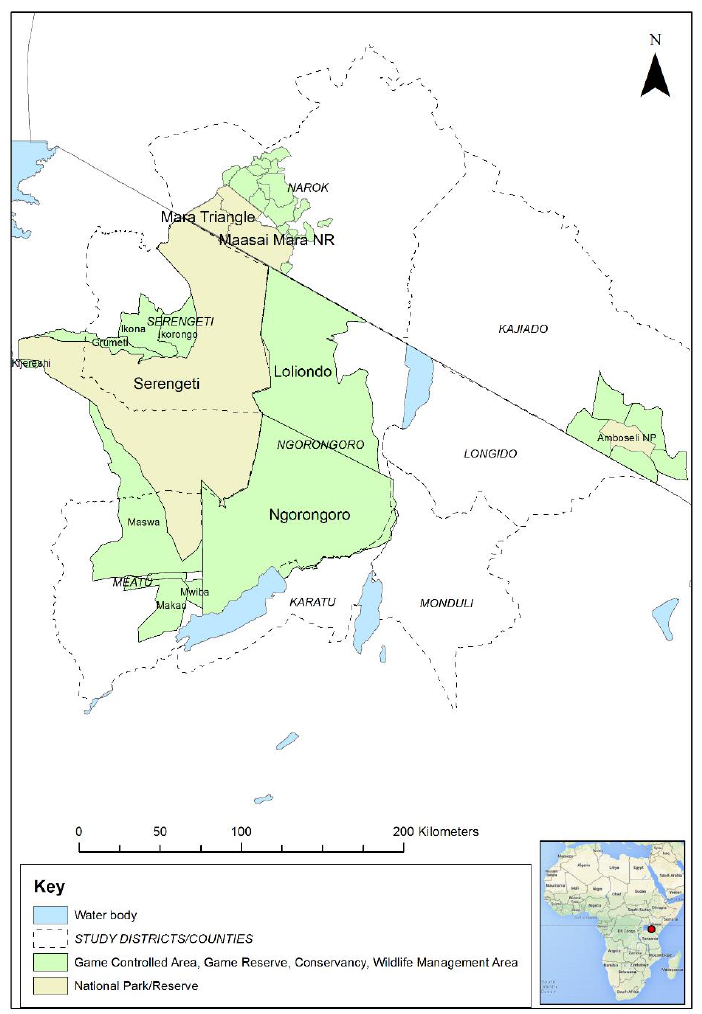
Figure 1. Map of the Greater Serengeti and Amboseli ecosystems showing protected areas and surrounding districts and counties in Tanzania and Kenya. Inset: map of Africa (Source: Map data © 2021 Google). The red dot indicates the location of the Greater Serengeti Ecosystem in northern Tanzania and southern Kenya.